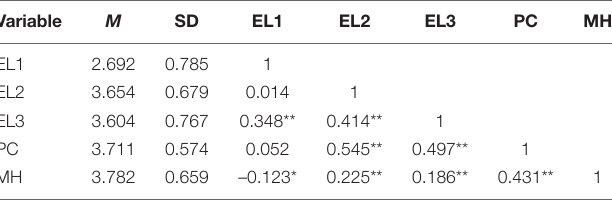
TABLE 1 | Descriptive statistics and correlation